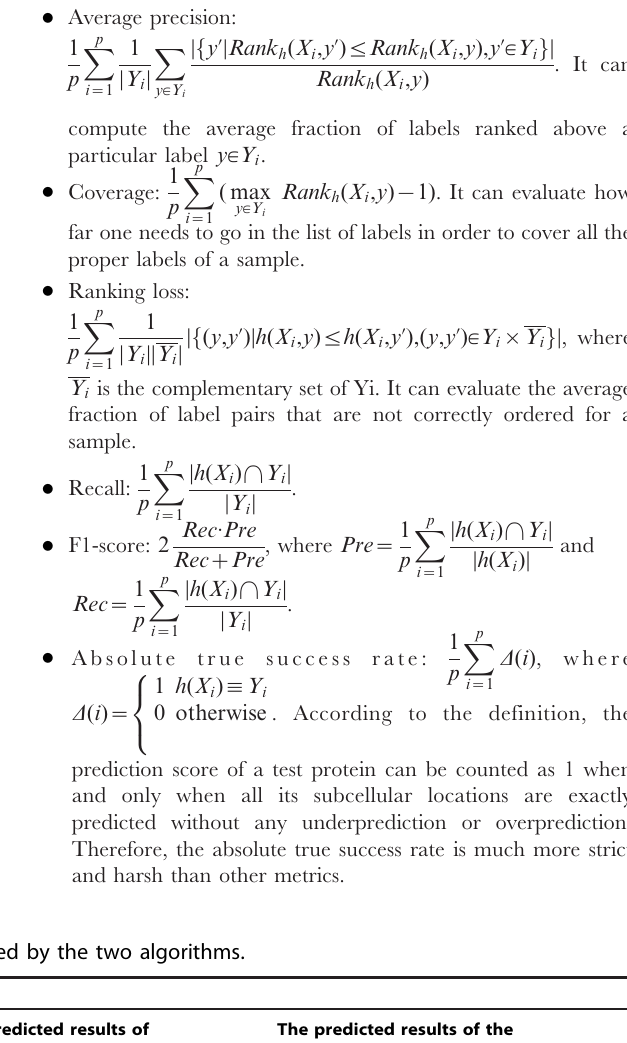
Accession number